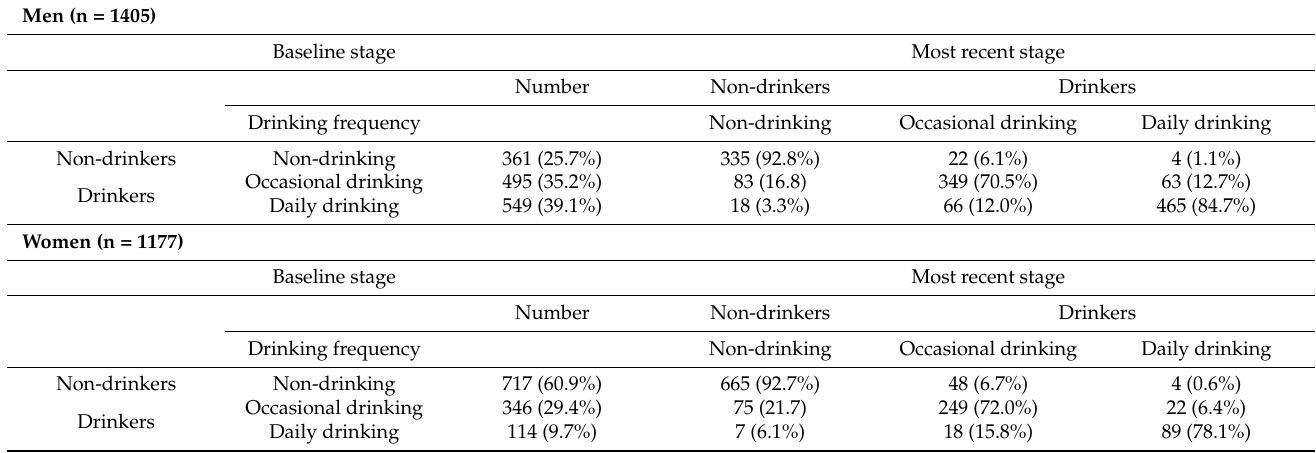
Table 3. Change in alcohol drinking frequency between baseline and final measurements (n = 2582) according to